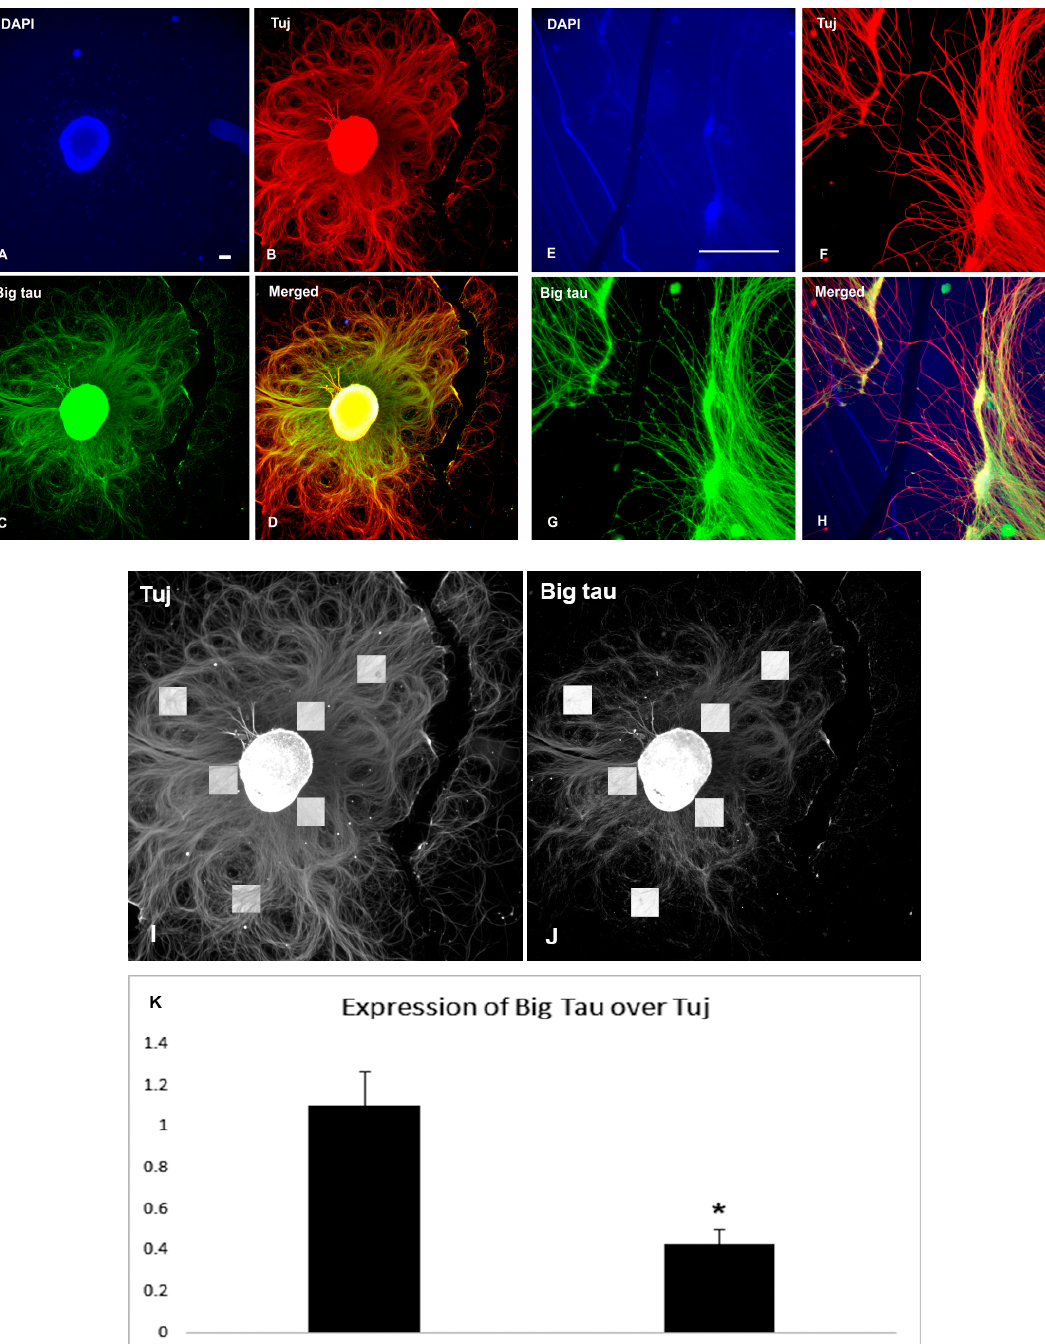
Figure 9. Big tau expression after SCG explant lesion (4 h). The analysis shows 2 sets of P3 SCG explants that were cultured for 8 days, and then grown for 4 h after lesion. Panels ( A – D ) show SCG explant lesion at low magnification. Panels ( E – H ) show SCG neurites growing near the lesion area at the high magnification. DAPI staining ( A , E ), Big tau staining ( C , G ), Tuj staining ( B , F ), and double staining ( D , H ) demonstrates neurite growth and expression of Big tau and Tuj 4 h after the lesion. The analysis of the ratio of Big tau/Tuj 4 h after lesion is based on data presented in ( B , C ). Panels ( I , J ) indicate the proximal and distal locations ( n = 3) of the areas included in the average density calculation, respectively, expressed as a ratio of Big Tau over Tuj ( K ). The ratios of Big tau/Tuj densities are significantly lower in the distal explant relative to proximal (* p = 0.02). Scale bar = 100 μ m.